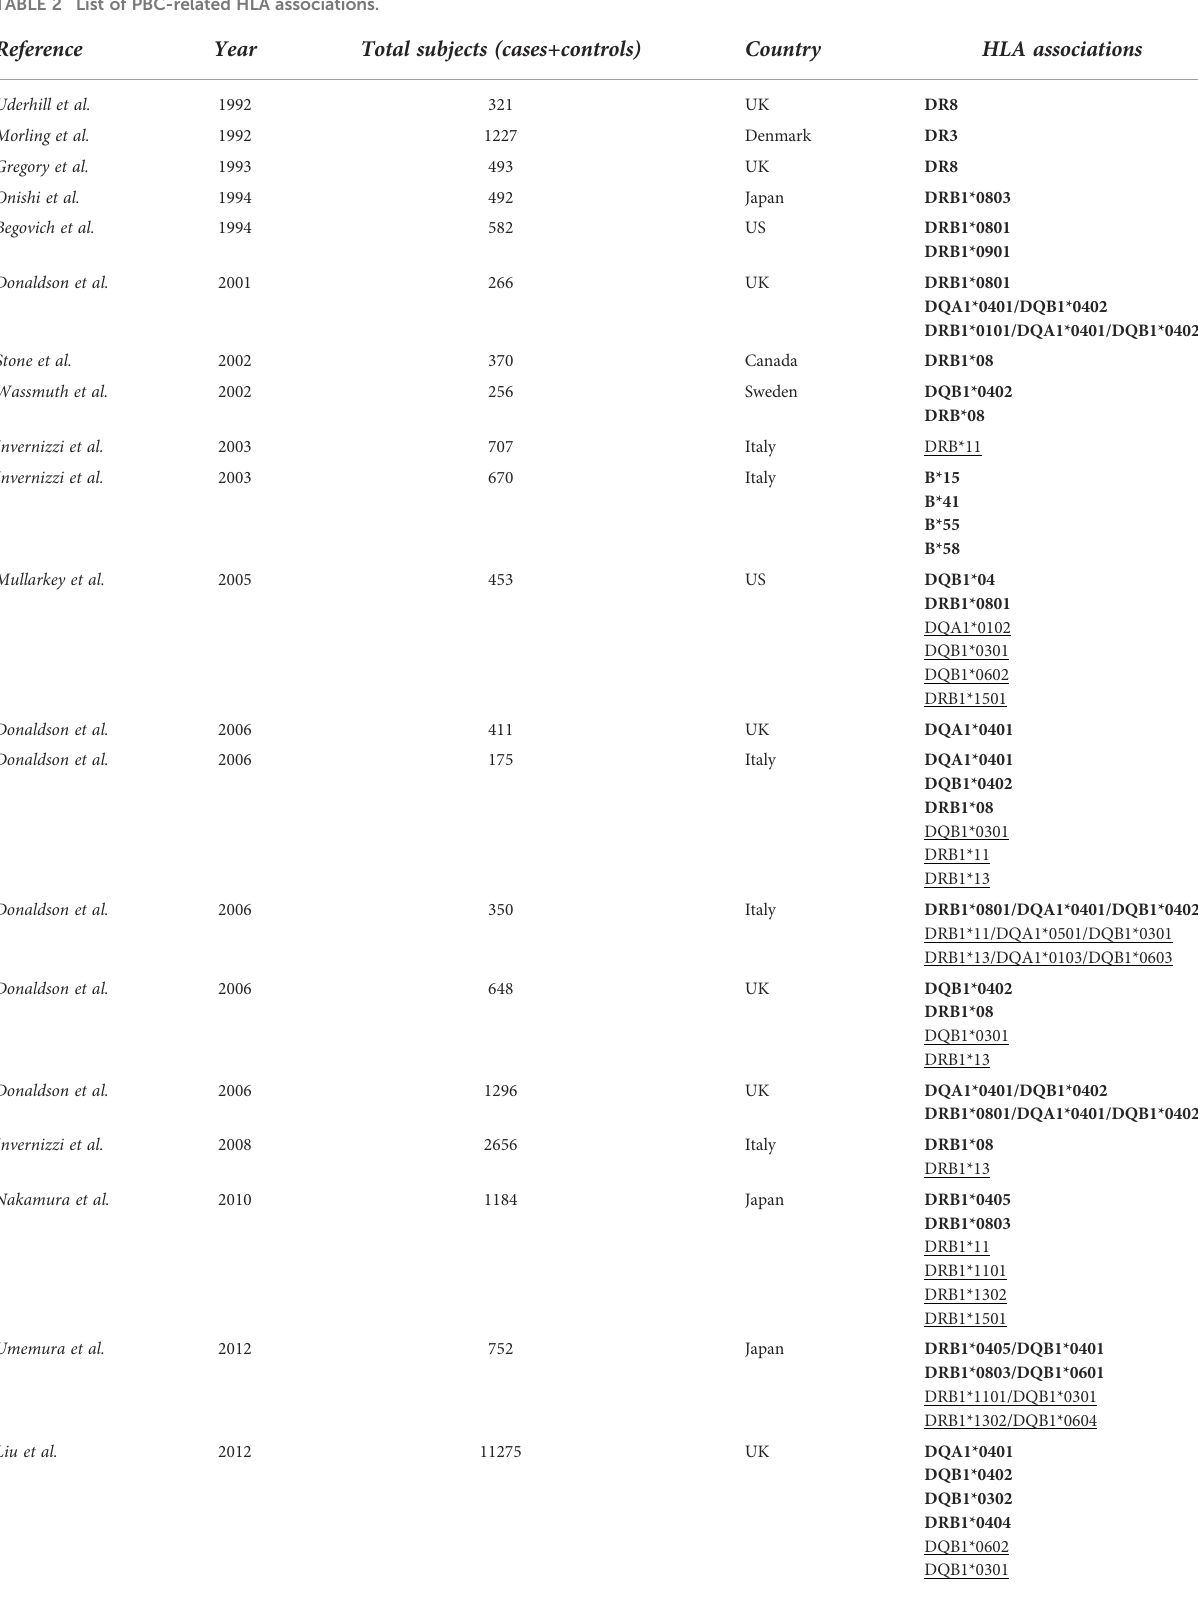
TABLE 2 List of PBC-related HLA